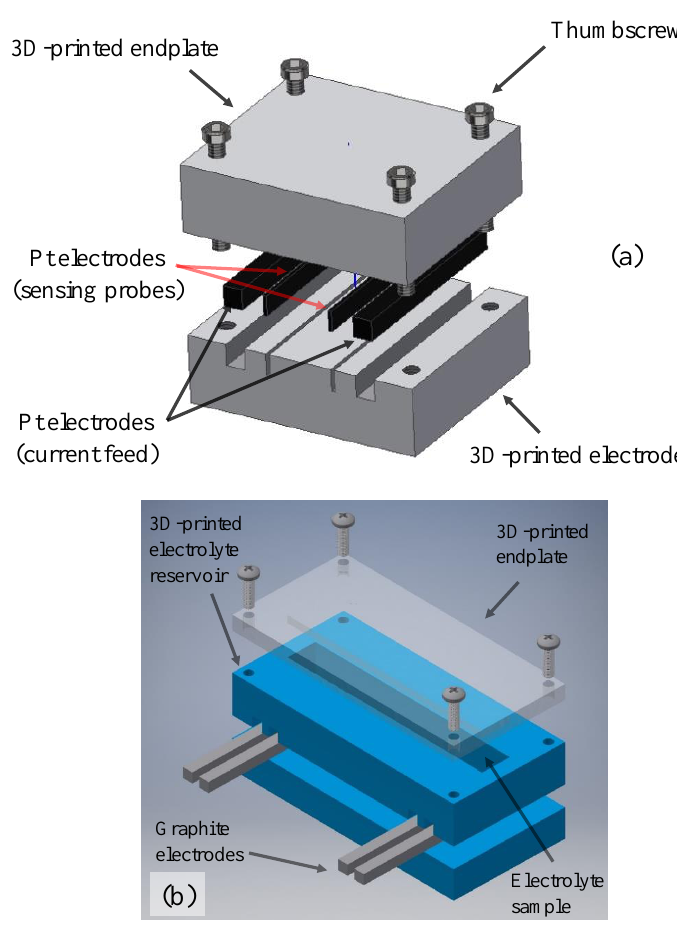
Figure 2. Schematic of the device designed in-house for measuring: ( a ) in-plane ionic conductivity of ion-exchange membranes (IEMs), ( b ) ionic conductivity of electrolytes [27].